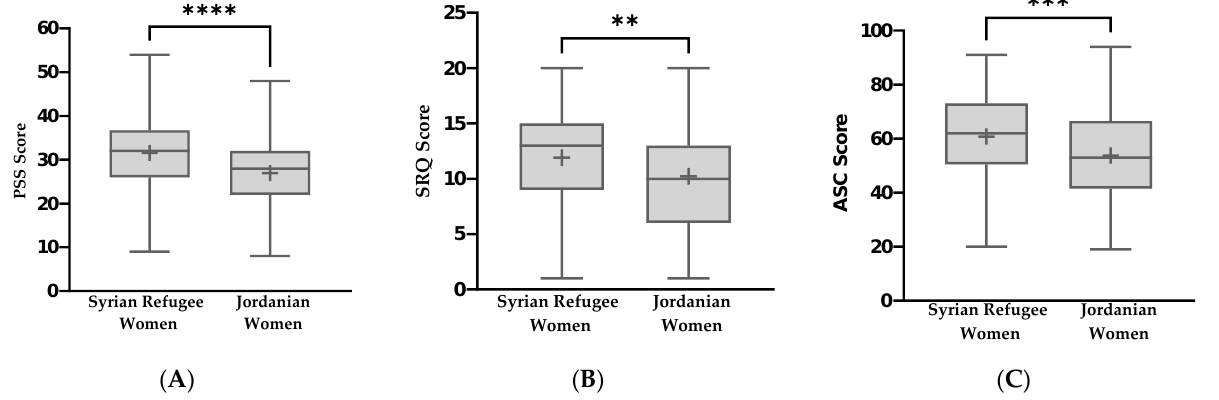
Figure 1. Comparison between Syrian refugee and Jordanian women in perceived stress and mental health measures. ( A ) Perceived Stress Scale (PSS) total score, ( B ) Self-Reporting Questionnaire (SRQ), and ( C ) Afghan Symptoms Checklist (ASC). Means are represented by (+) symbol, whiskers represent minimum and maximum values. Data were analyzed using an independent t -test. ** Significantly different at p < 0.01, *** Significantly different at p < 0.001, **** Significantly different at p <